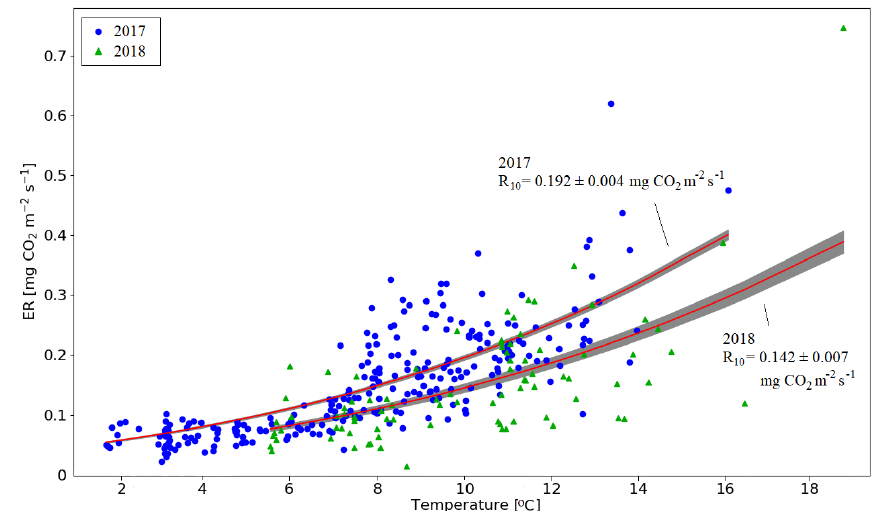
Figure A1. Temperature response of ecosystem respiration in the pine forest based on the nighttime EC data for 15 June–15 August 2017 and 2018. The lines show the fitted temperature response ER = R 10 × e E 0 ( The shaded areas indicate the one-sigma confidence intervals.